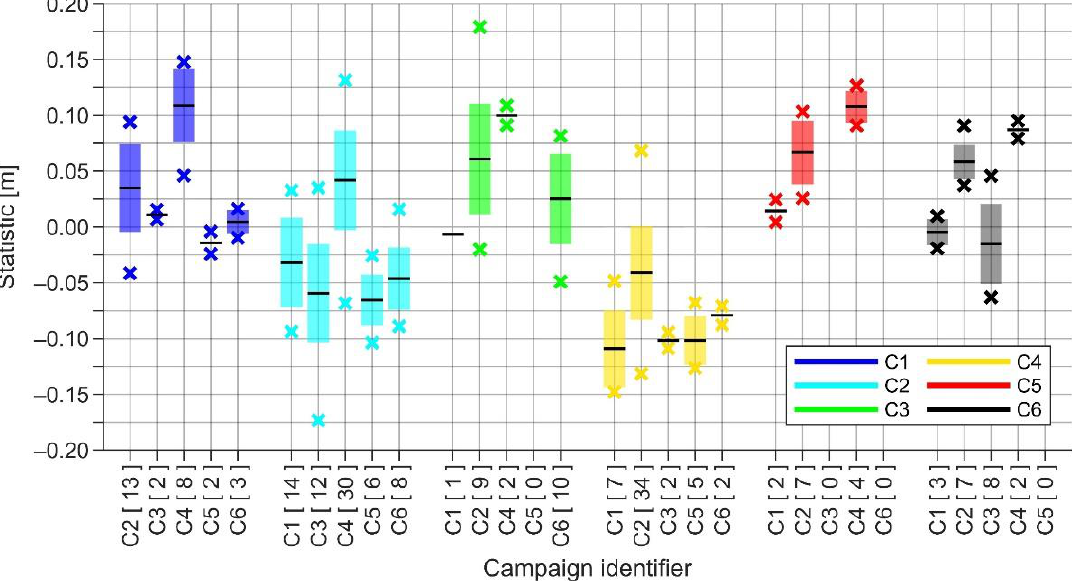
Figure 15. Statistical properties of filtered and corrected residuals’ differences at intersections between campaigns. The black lines are mean values, and colored bars denote standard deviation estimates. Crosses show minimum and maximum differences. Note that color shows the validated campaign and the X-axis validation dataset. In square brackets are the total number of detected intersections for each comparison.